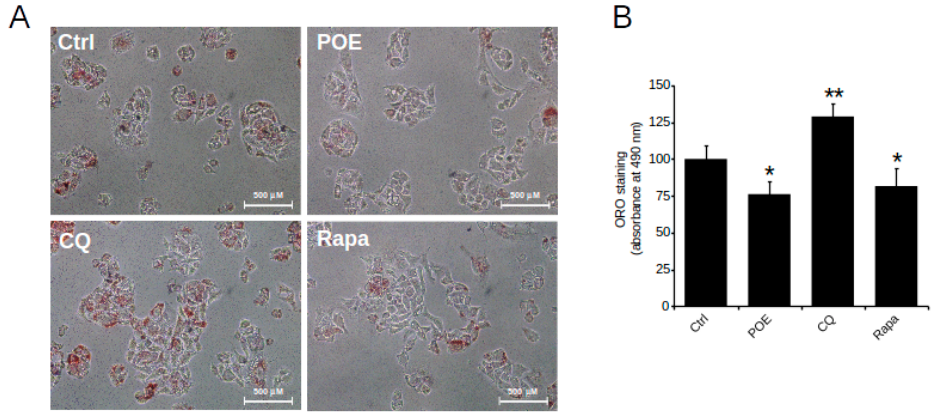
Figure 4. The effect of POE on lipid accumulation in HepG2 cells. ( A ) Representative image of ORO-stained HepG2 cells treated with POE (7.2 µ g/mL), CQ (10 µ M), and Rapa (0.5 µ M) for 24 h. ( B ) Changes in intracellular lipid content assessed by measuring ORO absorbance at 490 nm. Data were reported as the mean ± SD of at least three independent experiments. * p < 0.05; ** p < 0.01 vs. untreated control cells (Ctrl). Tukey’s HSD test.